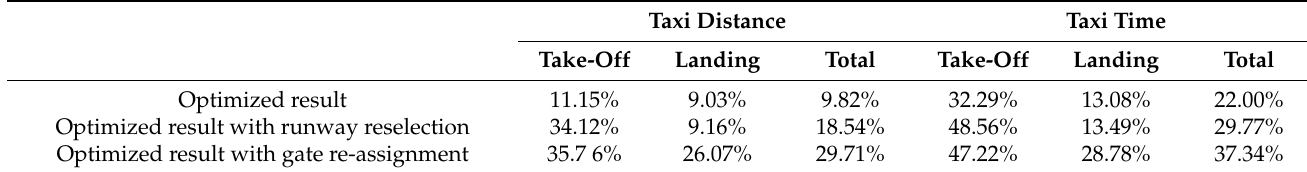
Table 5. Decreasing rate comparison with runway reselection and gate re-assignment. Taxi Distance Taxi Time Take-Off Landing Total Take-Off Landing Total Optimized